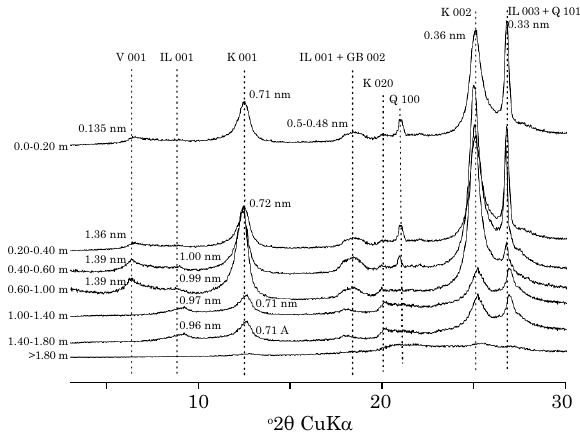
figure 1. Sequence of x ray diffractograms of clay fraction saturated with mg, showing the morphology of the vermiculite, illite, and kaolinite peaks in different soil layers in otacílio costa, Sc,